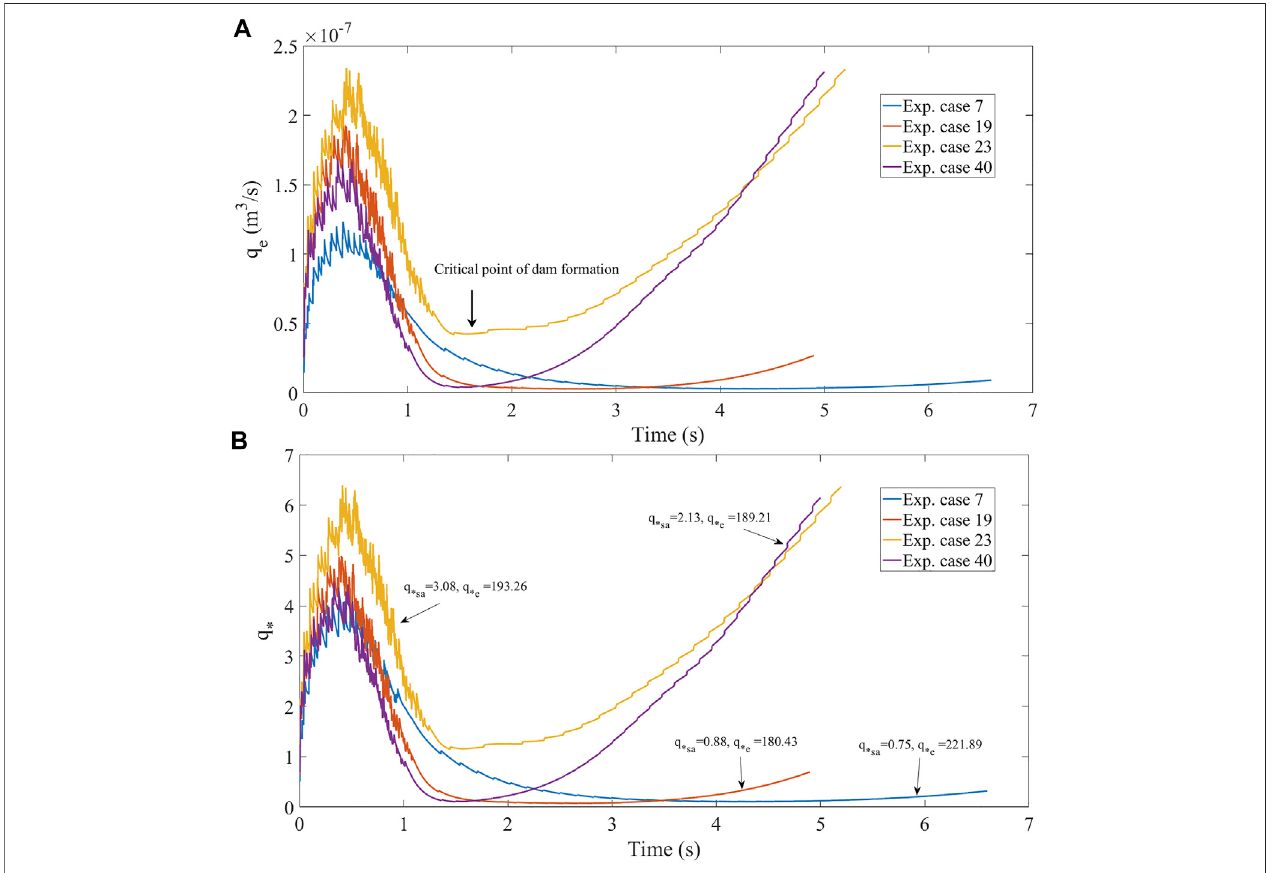
FIGURE 4 | Variation histories of (A) erosion rates and (B) dimensionless critical discharge for the experiment simulation cases 7, 19, 23, and 40. The arrow in the fi gure represents the critical point of dam formation. q *sa and q *e represent the average value of q * calculated with the data from the simulation and Chen et al. (2019a),